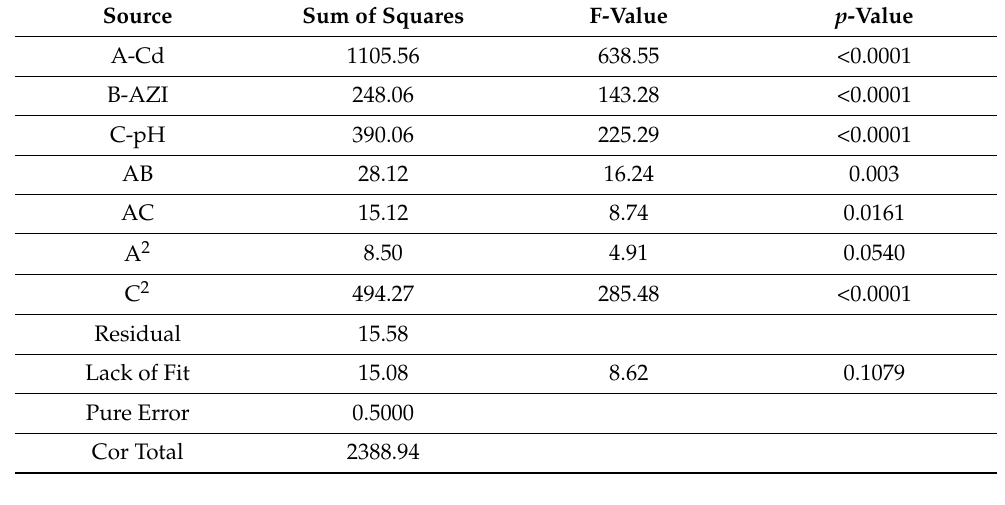
Table 5. ANOVA results for the quadratic model for Cd and AZI at different soil pH.